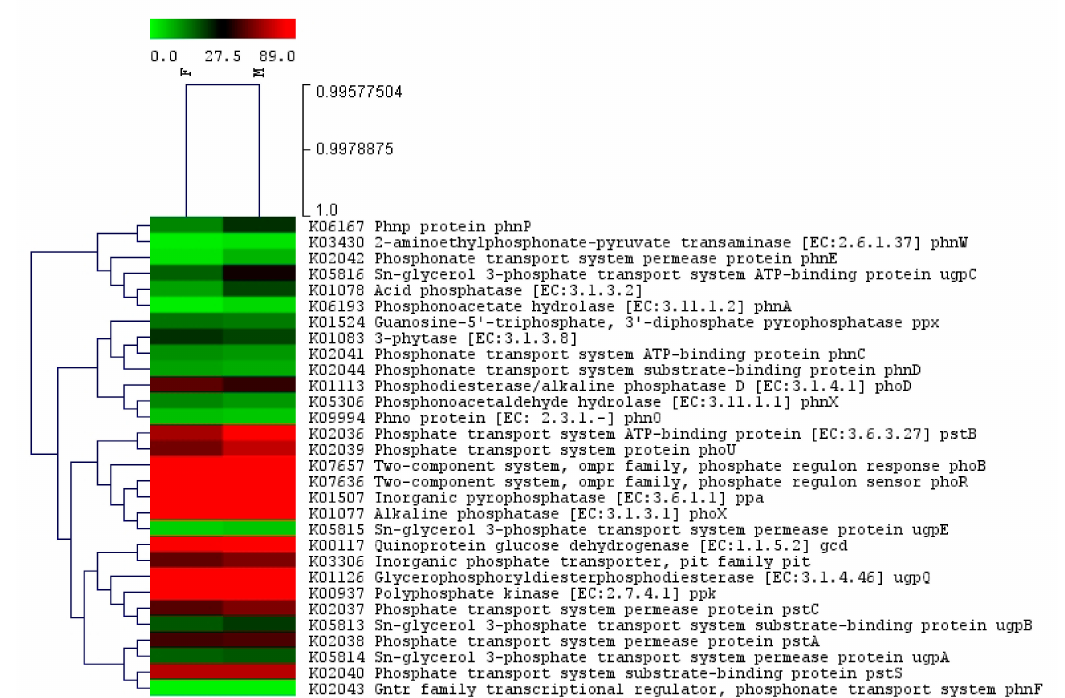
Figure 8. Heat tree of 30 genes of bacterial communities related to the phosphorus cycling process in lentil cultivars Moitree (M) and Farmer-2